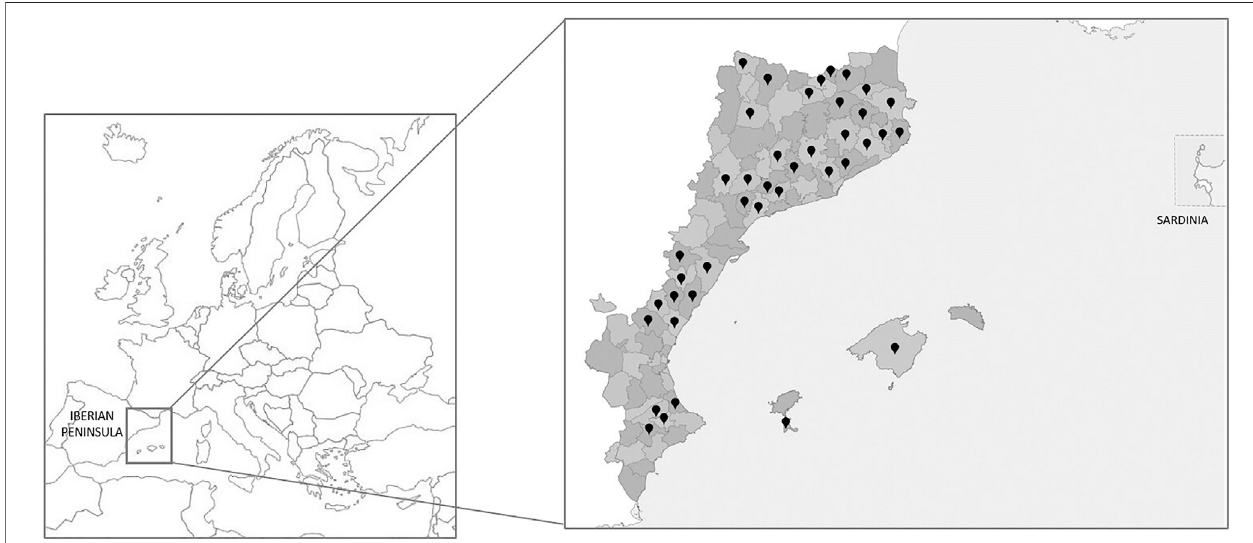
FIGURE 1 | Map of the territories studied within Europe and the Catalan linguistic area. Dots indicate the areas with prospections analyzed in the present